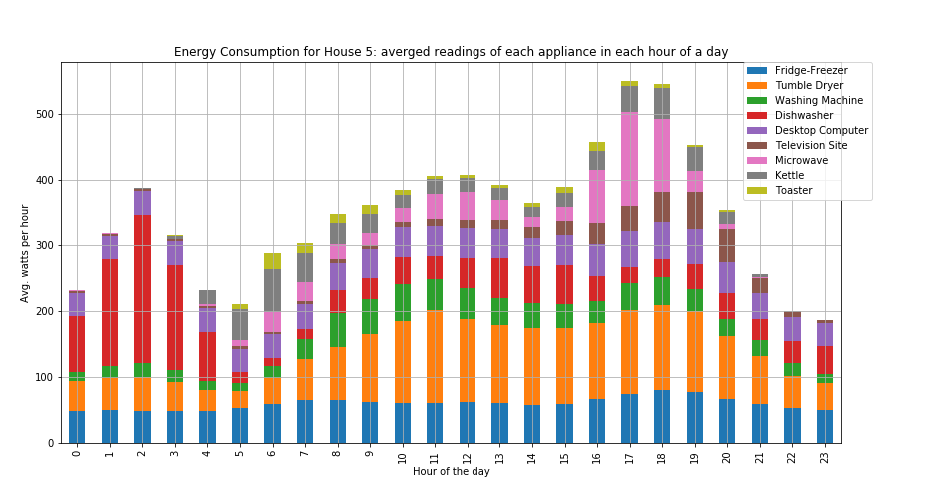
Figure A7. The average consumption per hour of home appliances for house 5 with four occupants.